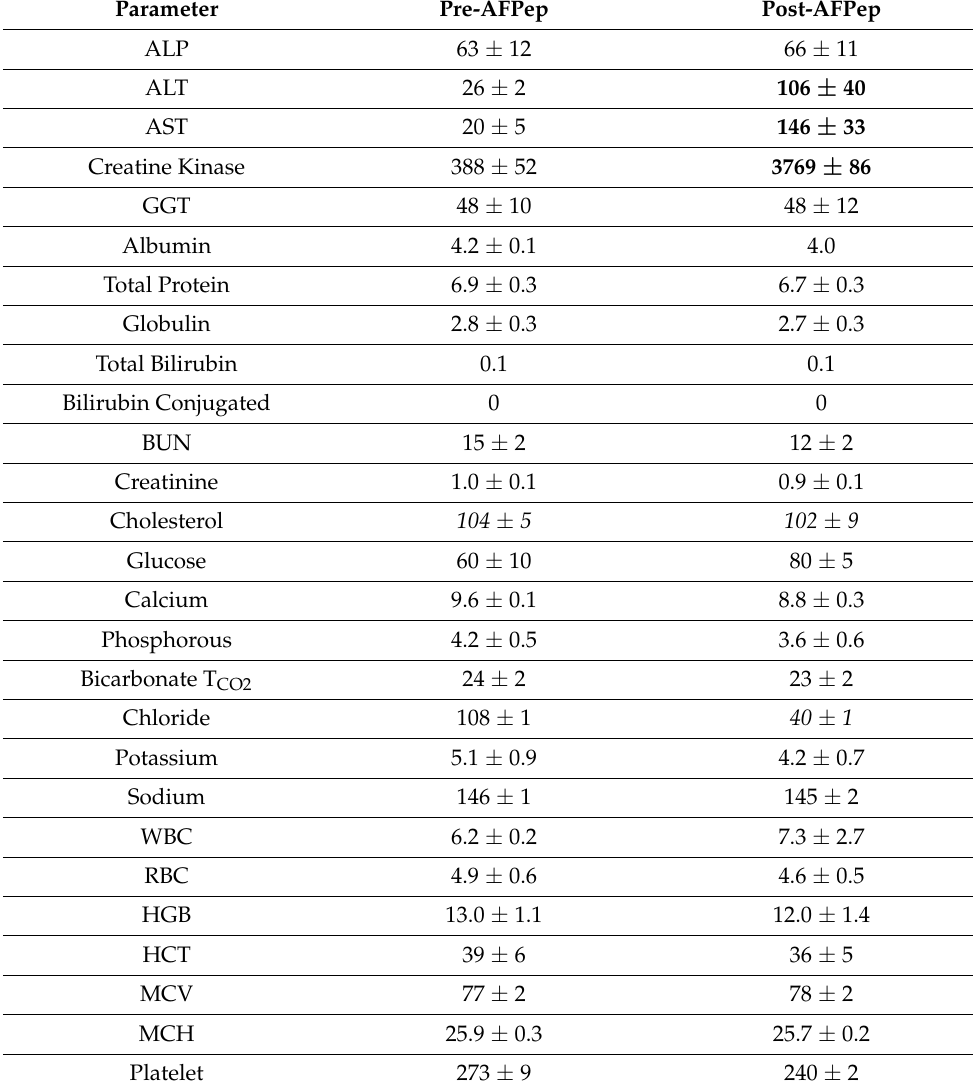
Table 4. Blood chemistry and hematology values before and 24 h after the intravenous administration of 40 mg AFPep to